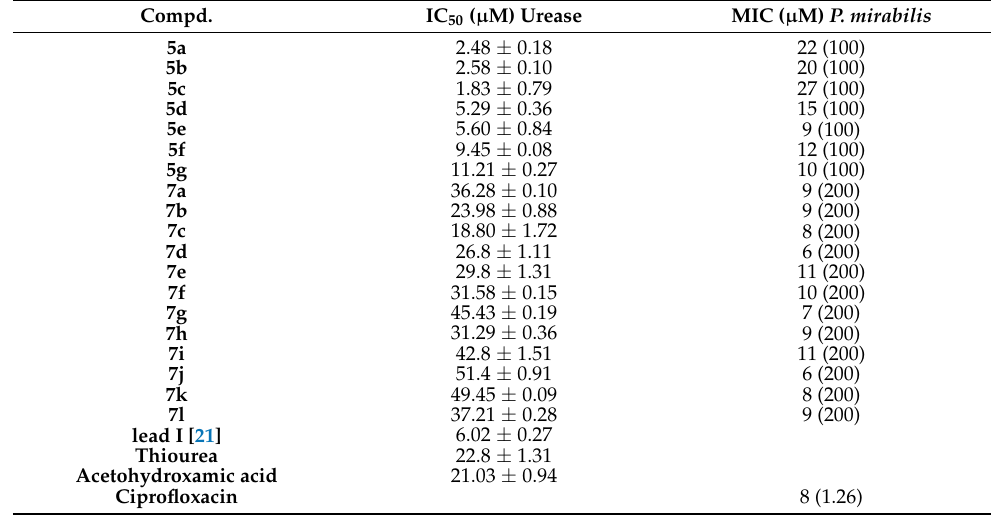
Table 2. Urease inhibition IC 50 ( µ M), anti- P. mirabilis , expressed as inhibition zone in mm and MICs (in µ g/mL, given in brackets) of compounds 5a – g and 7a – l .